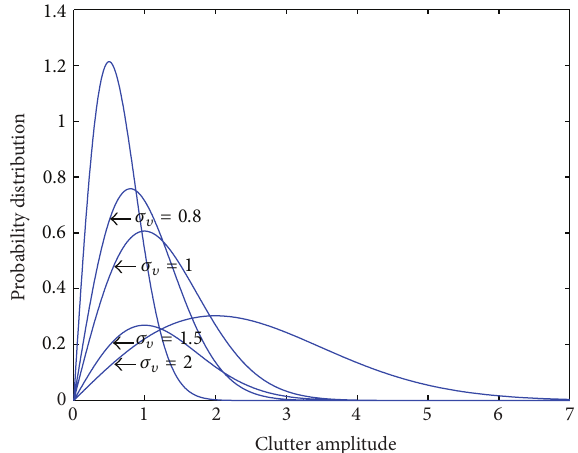
Figure 7: Probability distribution of Rayleigh clutter.